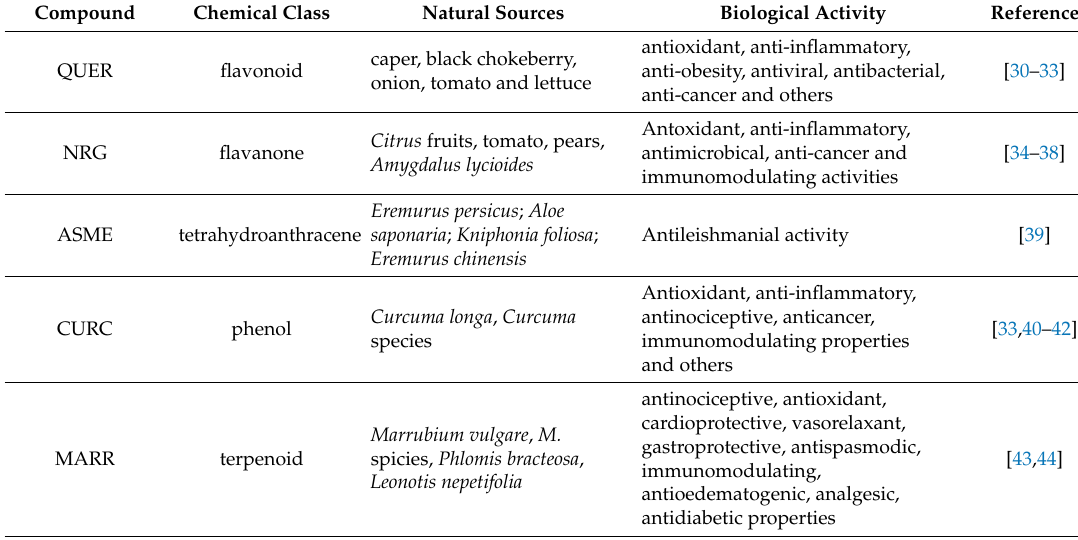
Table 1. Biological activity, natural sources, and chemical class of the compounds